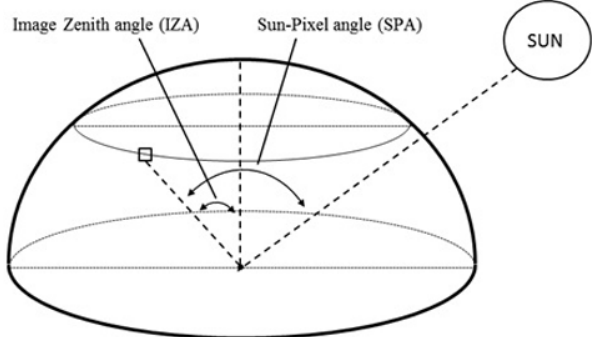
Fig. 2. Spherical mirror of the TSI and solar geometry. The thick black line shows the TSI’s spherical mirror. The square on the left shows a particular pixel for illustration purposes. The sun-pixel an- gle is the angle between the solar direct beam and the pixel. The thin black circle is drawn through the pixel and denotes a line of constant Image Zenith Angle (IZA). IZA is the angle between the pixel and a vertical line through the center of the imager.